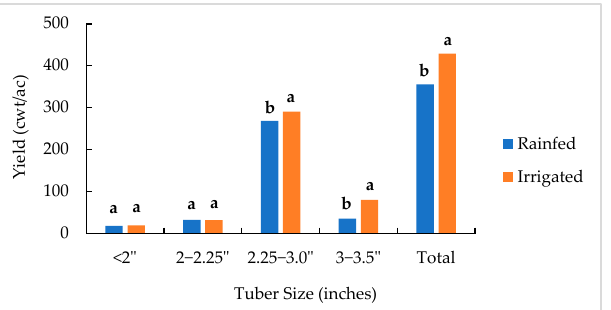
Figure 2. Tuber yields (cwt/ac) under rainfed and irrigated plots in different tuber sizes (in inches) different at p < 0.05 according to the Fisher LSD method. of the three-year trial. Means not sharing a common letter in two adjacent columns are significantly different at p < 0.05 according to the Fisher LSD method.